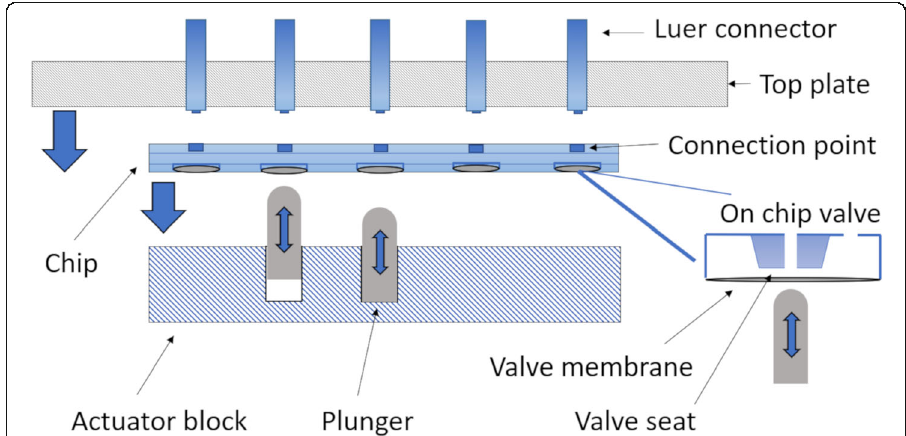
Fig. 9 Functionality of chip clamping and on-chip membrane valves. The top plate clamps the chip down against the extended plungers. The plungers press the valve membranes inwards against the valve seats and close therefore the valves are normally closed. In the same clamping motion, the luer connectors are joined together with the connection points on the chip